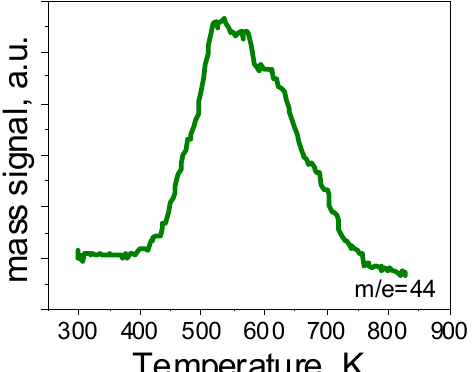
Figure 6. TPO of the 1.5AuSZ2 sample after reaction.